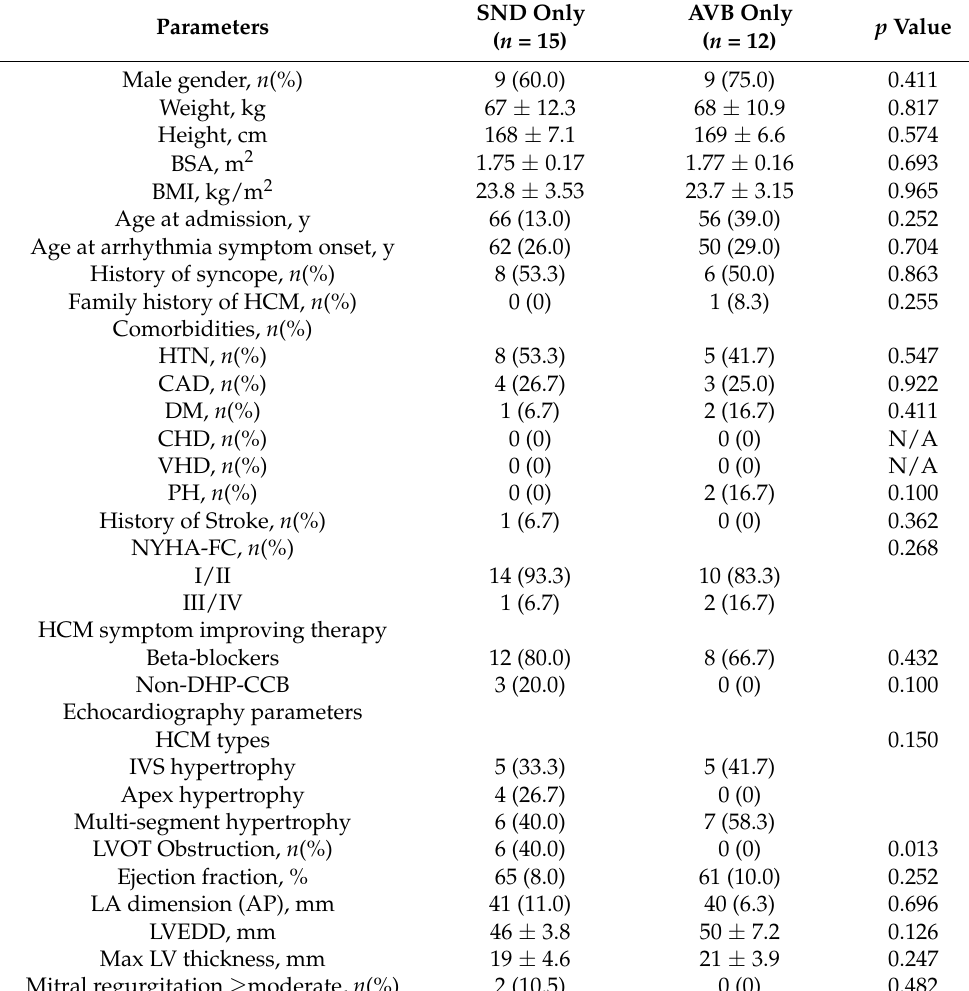
Table 3. Comparisons between patients with SND and patients with AVB. Parameters